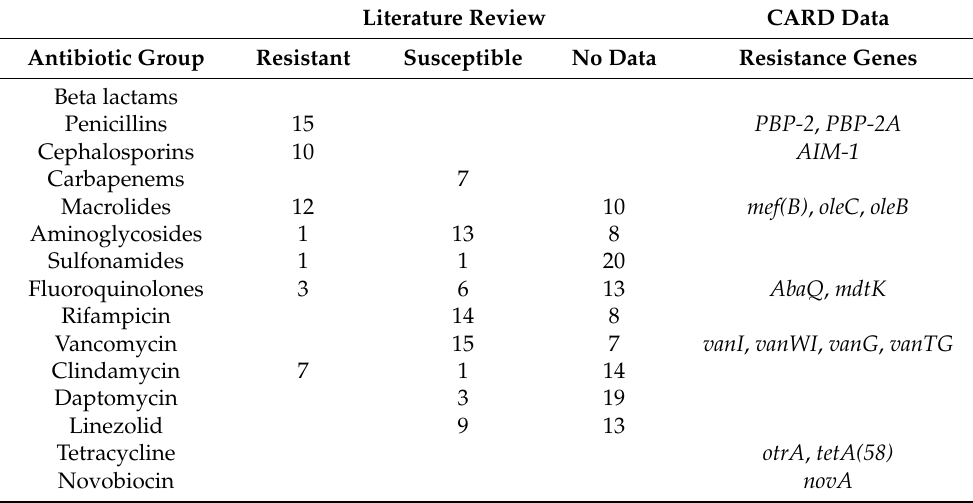
Table 1. Analysis of antibacterial